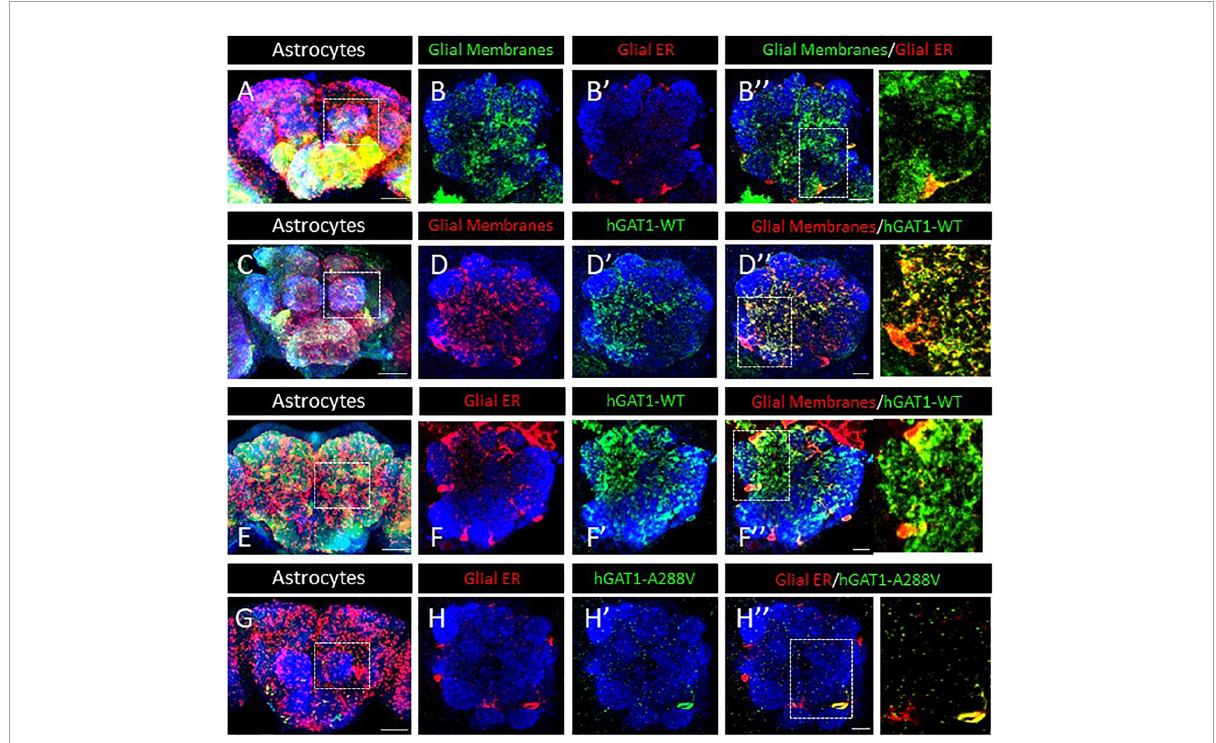
FIGURE3 Human GABA transporter 1 (hGAT-1) A288V mutant shows ER retention in adult fly brain. (A,B) Organization of astrocytes in the adult Drosophila central brain. Cell bodies of astrocytes cover the brain surface, also around the antennal lobes (dashed line in A). (B–B”) Astrocyte membranes penetrate into the AL neuropile (B) , while the glial ER compartments are restricted to the peripheral cell bodies (B’, B”) . (C,D) Distribution of a wild type YFP-hGAT-1 transgene in astrocytes of the adult brain (C) and in the antennal lobes with a co-localization of wild type YFP-hGAT-1 with central neuropile glial processes (D–D”) . (E,F) Distribution of a wild type YFP-hGAT-1 transgene in astrocytes of the adult brain (E) and in the antennal lobes with only minor co-localization of wild type YFP-hGAT-1 with the ER compartment in peripheral glial cell bodies (F–F”) . (G,H) Distribution of a mutant YFP-hGAT-1-A288V transgene in astrocytes of the adult brain (E) and in the antennal lobes. No YFP-hGAT-1-A288V can be detected in most astrocytes and in rare cases of visible protein expression YFP-hGAT-1-A288V is restricted to the endoplasmic reticulum (ER) compartment (H–H”) . Scale bar for panel (B,D,F,H) is 10 µ m and for panel (A,C,E,G) is 50 µ m. Genotypes: (A–B”) :; UAS-KDEL-RFP/ALRM Gal4; UAS-mCD8-GFP/ + ; (C–D”) :; ALRM Gal4/ + ; UAS-YFP-hGAT-1 WT/UAS-mCD8-GFP (E-F”):; UAS-KDEL-RFP/ALRM Gal4; UAS-YFP WT-hGAT-1/ + ; and (G–H”) :; UAS-KDEL-RFP/ALRM Gal4; UAS-YFP-hGAT-1-A288V/ + ; . Each image is representative of at least 10 additional images per condition. Neuropiles are labeled by NCAD in